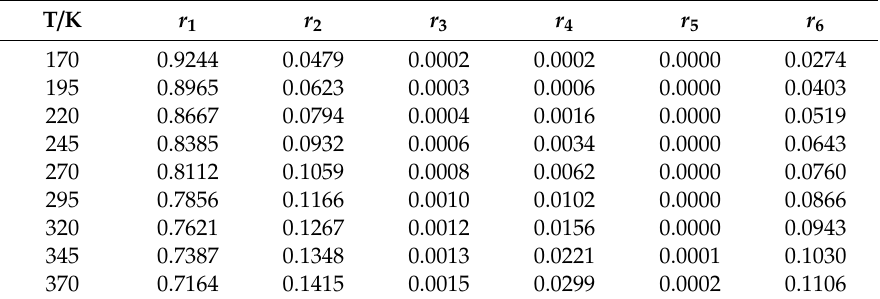
Table 2. The branching ratios ( r i ) for the entrance channels at 1 atm and over the temperature range of 170–370